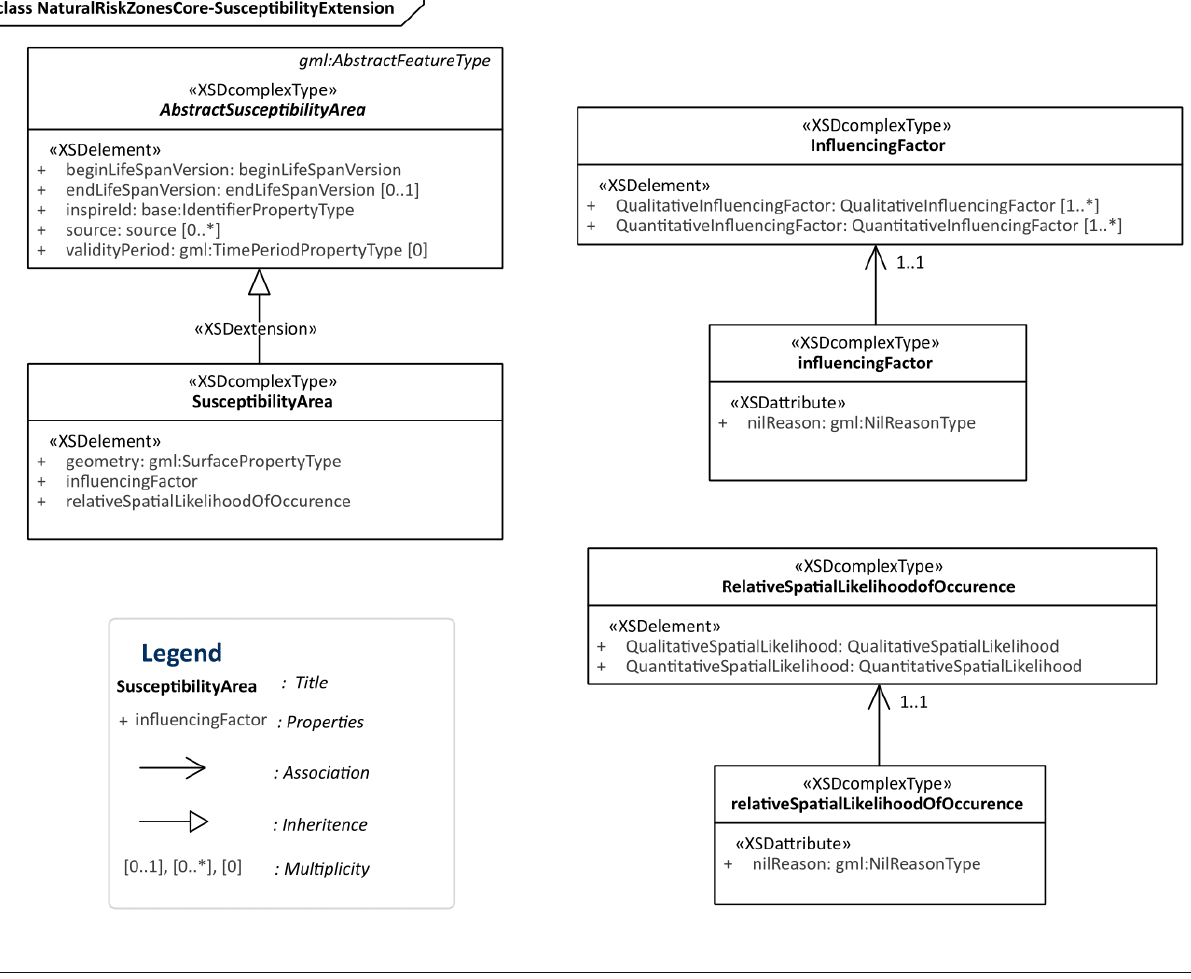
Figure 4. UML diagram showing Natural Risk Zone Susceptibility schema extension of the Natural Risk Zone core schema. Table 2. INSPIRE-compliant